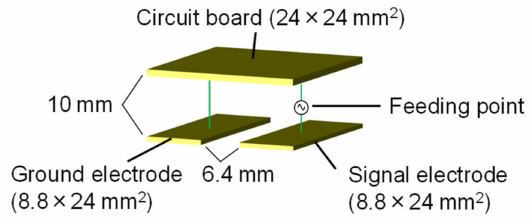
Figure 3. Structure of the wearable antenna prototype.